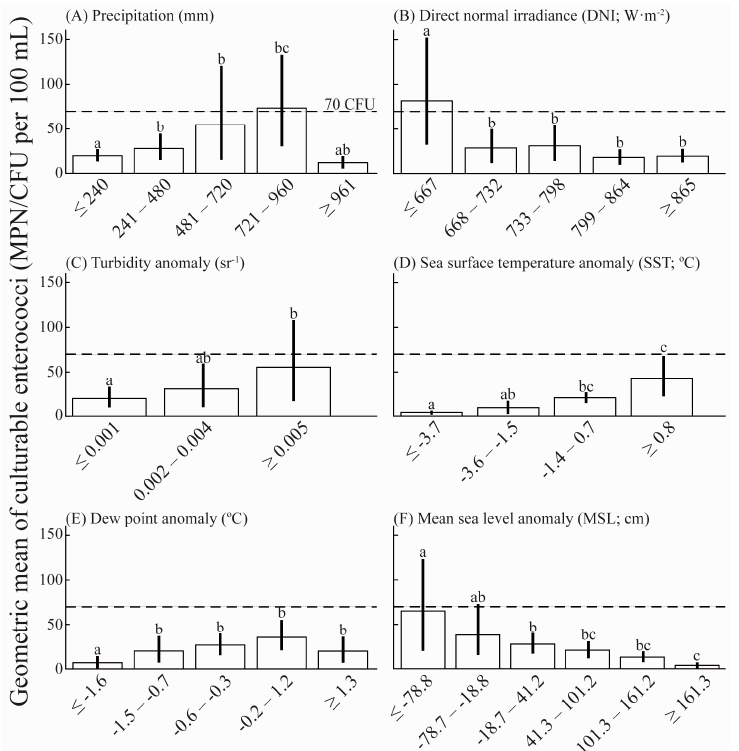
Figure 2. Geometric mean of enterococci concentrations in Escambron Beach surface waters at different ranges of ( A ) precipitation; ( B ) direct normal irradiance (DNI); ( C ) turbidity anomaly; ( D ) sea surface temperature anomaly (SST); ( E ) dew point anomaly; and ( F ) mean sea level (MSL) anomaly at Escambron Beach during 2005–2015. Dashed lines are the 2014 US EPA beach action value (BAV) of 70 CFU/100 mL (US EPA 2012; 2014). Vertical lines represent the 95% confidence interval. Lower-case letters above the vertical lines identify statistically significant differences among bins ( α = 0.05). Conversely, DNI and MSL showed a strong, negative correlation with enterococci concentrations in Escambron Beach surface waters. The highest correlations were observed after a 24- h lag for DNI, and a nine-day lag for MSL anomalies (Table 1). Higher culturable enterococci concentrations, exceeding the 2014 US EPA BAV and 2012 US EPA RWQC recommendation 1, were observed during the lowest DNI ( ≤ 667 W·m − 2 ; Figure 2B) as well as during the lowest negative MSL anomalies ( ≤− 18.8 cm; Figure 2F). Culturable enterococci concentrations decreased as DNI increased (>~668 W·m − 2 ; Figure 2B). Wind data (i.e., average wind speed, u-component, and v-component)